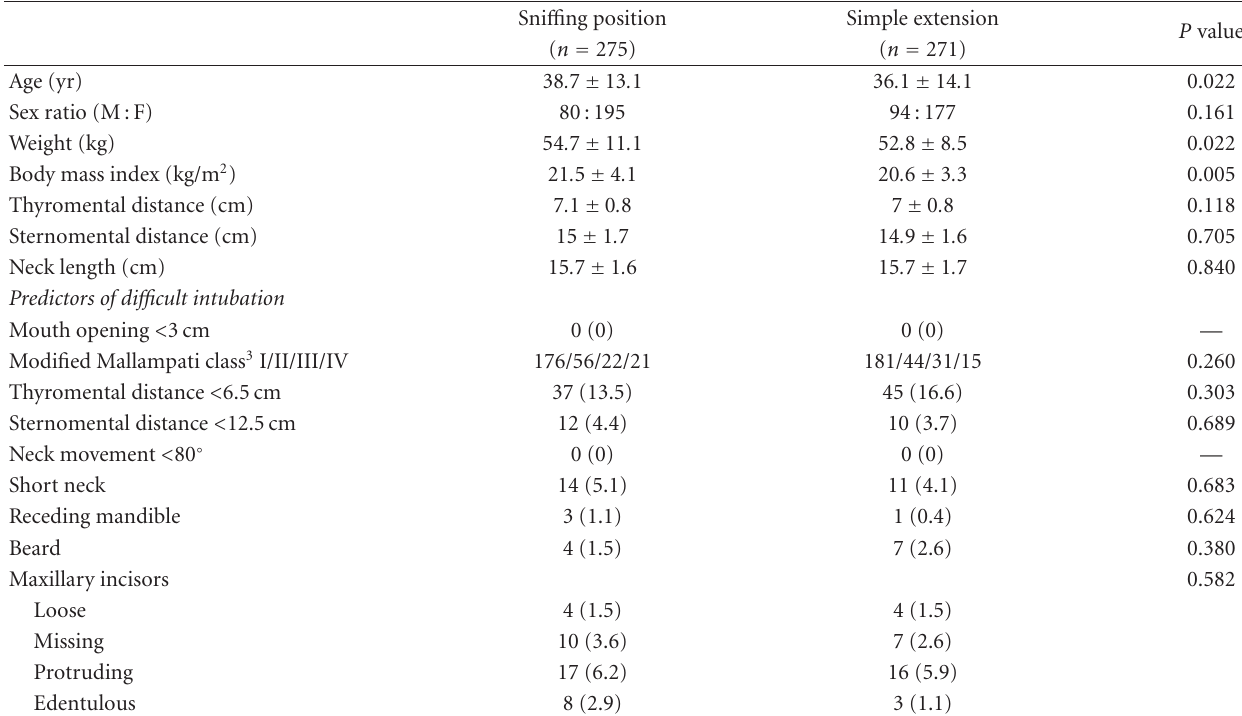
Table 1: Patient characteristics.